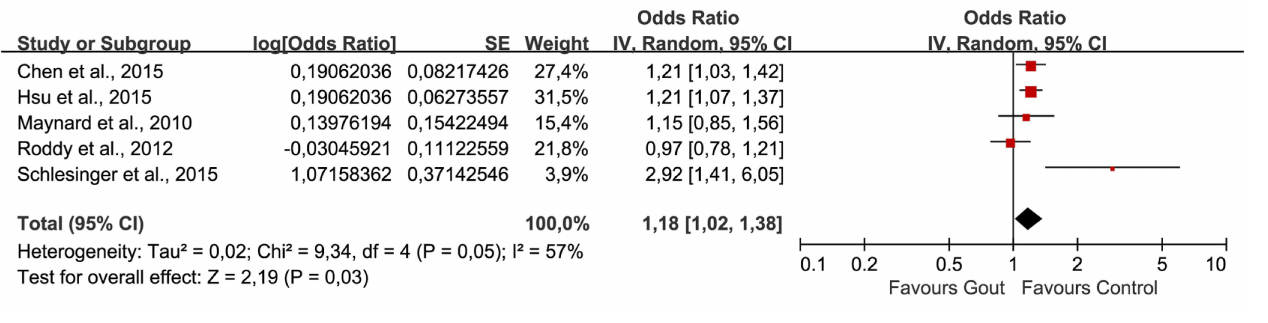
PLOS ONE | DOI:10.1371/journal.pone.0168784 December30,